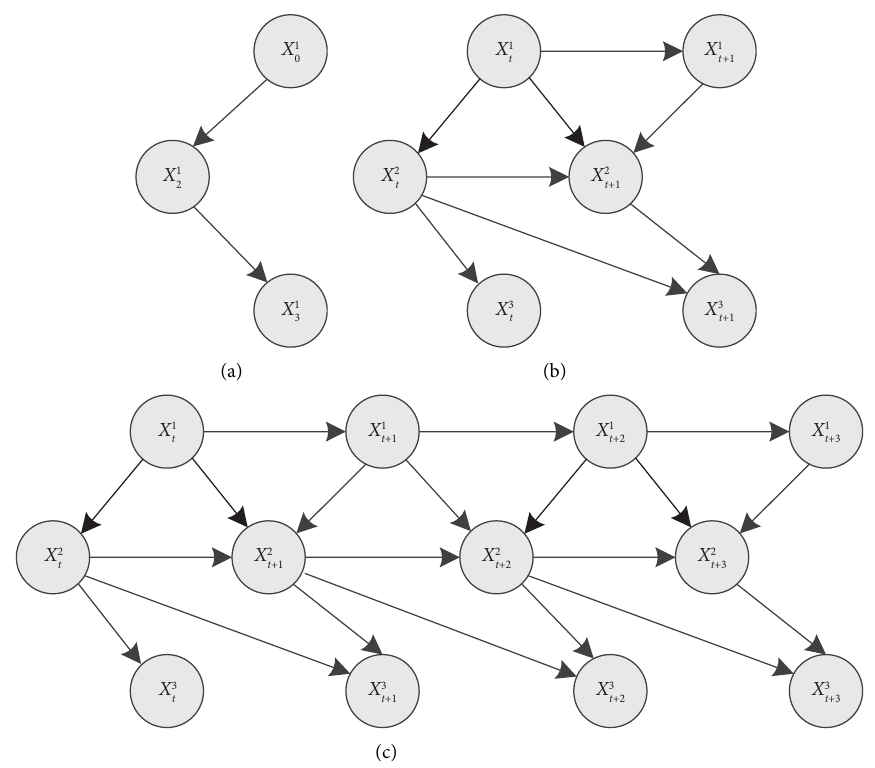
Figure 4: Graphic representation of dynamic Bayesian